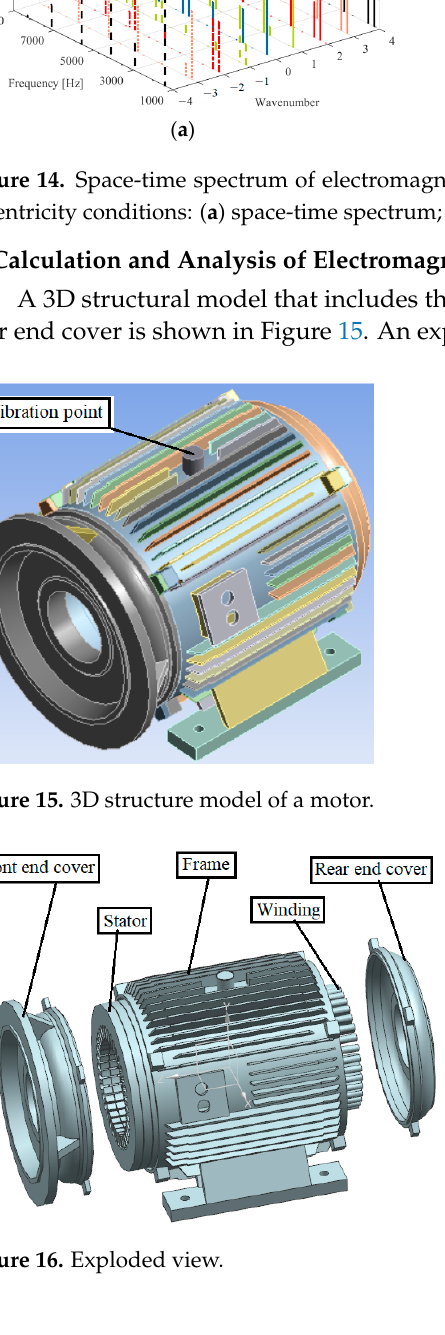
Figure 16. Exploded view.